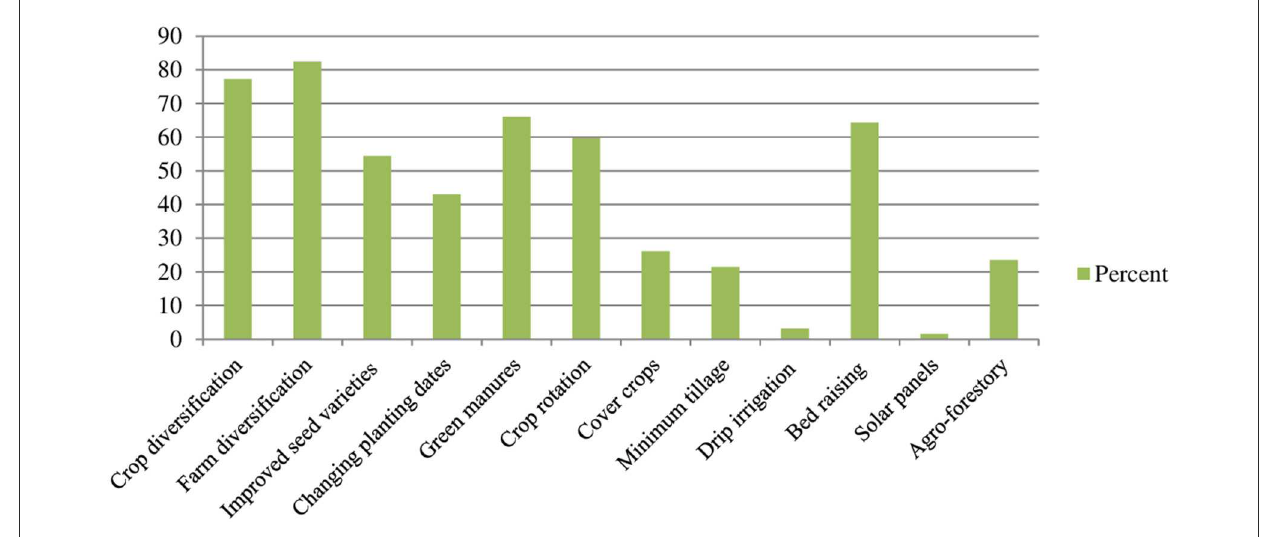
FIGURE1 Climate change adoption status in the region.